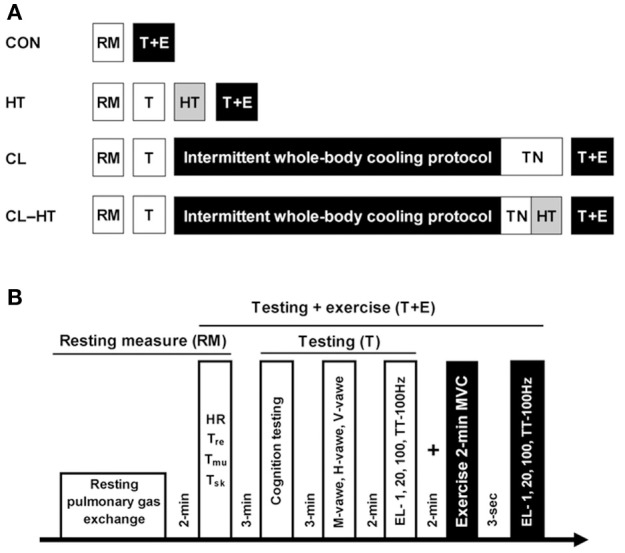
Experimental design (A). RM, resting measure; HT, 5-min warming in Tw; TN, thermoneutral environment (Ta); T, testing; T+E, testing with the 2-min MVC exercise. Protocols for the experimental trials (B). Heart rate (HR), body temperatures (rectal, Tre; muscle, Tmu; skin, Tsk); cognition testing (simple, 2-choice and procedural reactions); sarcolemmal (M-wave), spinal (H-wave), and supraspinal (V-wave) excitability; effects of electrical stimulation [EL; i.e., 1, 20, 100 Hz and TT-100 Hz (a 250-ms test train of stimuli at 100 Hz)] on relaxed muscle indicate changes in peripheral capacity; maximum voluntary contraction (MVC) indicates changes in both central and peripheral capacity; central activation ratio was measured by TT-100 Hz superimposed on a 2-min MVC and indicates changes in central capacity.